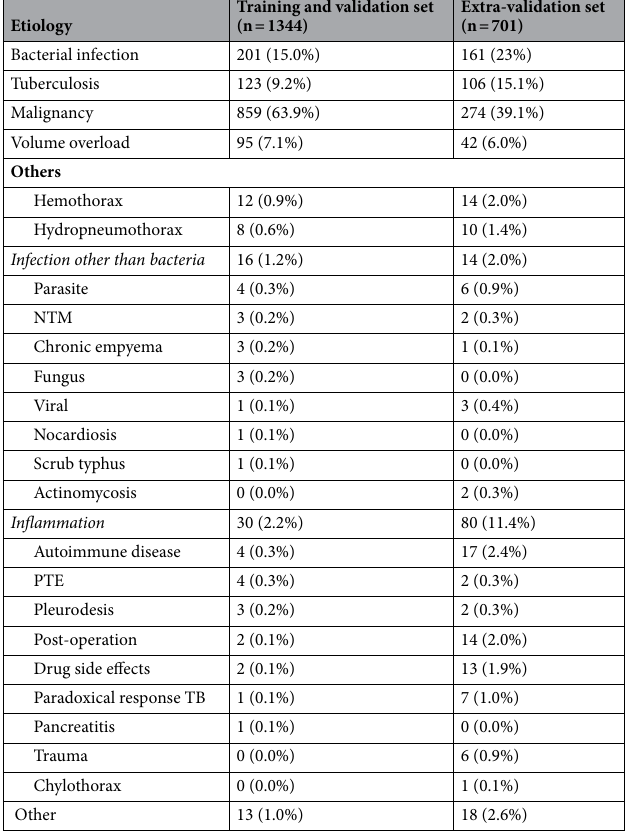
Table 1. The etiology distribution of pleural effusion in the datasets. Data are n (%). NTM: nontuberculous mycobacteria; PTE: pulmonary thromboembolism; TB: